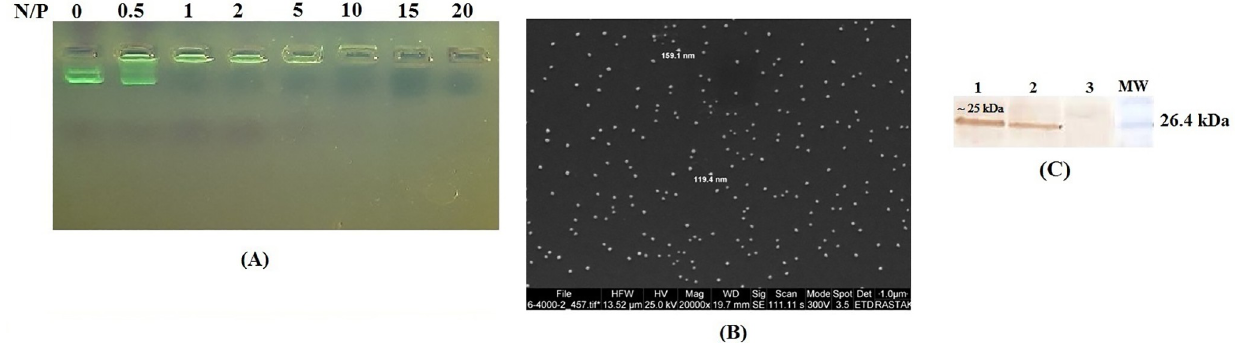
Fig 5. Formation of the LL37/ pcDNA- s-n-m nanoparticles: A) Gel retardation assay at N/P ratios of 0, 0.5, 1, 2, 5, 10, 15 & 20 on 1% agarose gel; B) SEM images of the LL37/ pcDNA- s-n-m nanoparticles. Images were taken under 2 × 10 4 magnification; C) Transfection efficiency of LL37 peptide and TurboFect for delivery of pcDNA- s-n-m into HEK-293T cells using western blot analysis. MW: molecular weight (14.4–97.4 kDa, Fermentas); Lane 1: Cells transfected with the pcDNA- s-n-m /LL-37 nanoparticles; Lane 2: Cells transfected with the pcDNA- s-n-m /TurboFect complexes; Lane 3: Untransfected HEK-293T